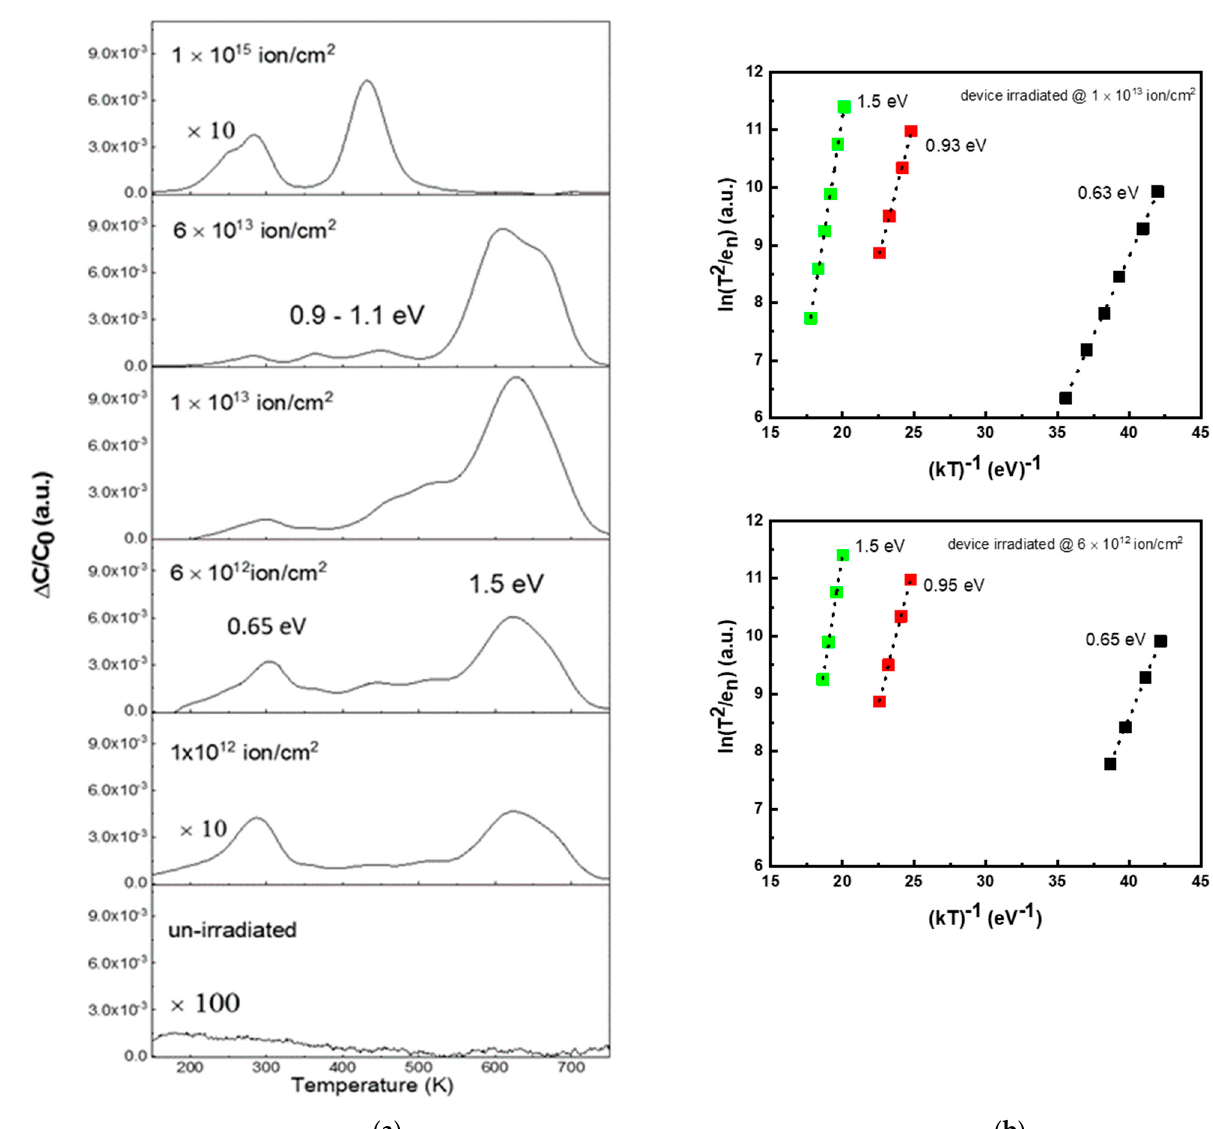
Figure 6. Deep-level transient spectroscopy (DLTS) spectra of un-irradiated and different fluences of irradiated devices. The energies of the main produced levels are indicated ( a ). Arrhenius plots obtained from DLTS spectra for the diodes irradiated at fluences of 6 × 10 12 ions/cm 2 and 1 × 10 13 ions/cm 2 ( b ).